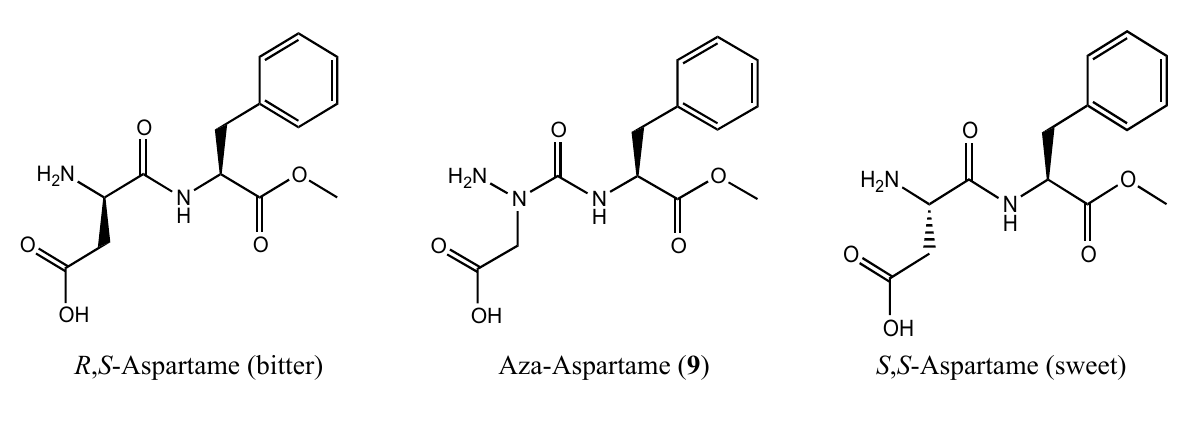
Figure 4. Aspartame isomers and [aza-Asp 1 ]-aspartame 9